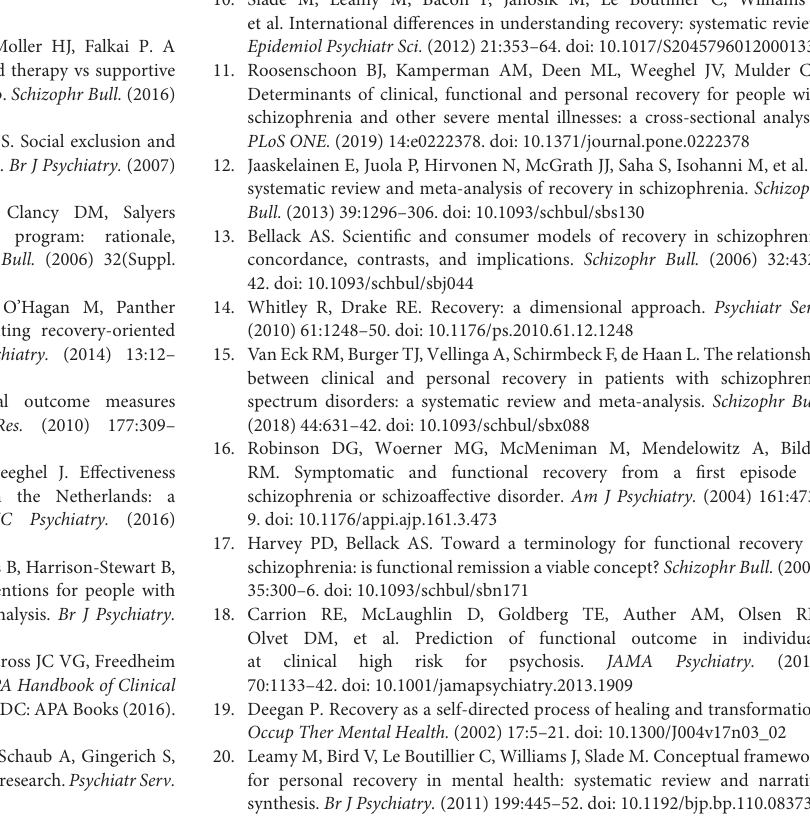
Supplementary Table 1 | Coefficients, odds ratios and CI ’s, predicting non-completion from baseline characteristics. Supplementary Data Sheet 1 | Positive decision Erasmus MC. Supplementary Data Sheet 2 | Original study Protocol for the